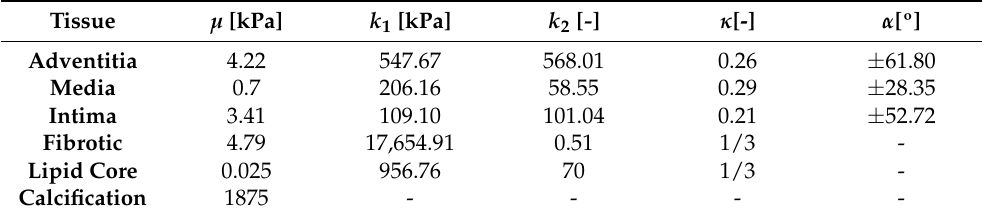
Table 1. Fitted parameters for the hyperelastic